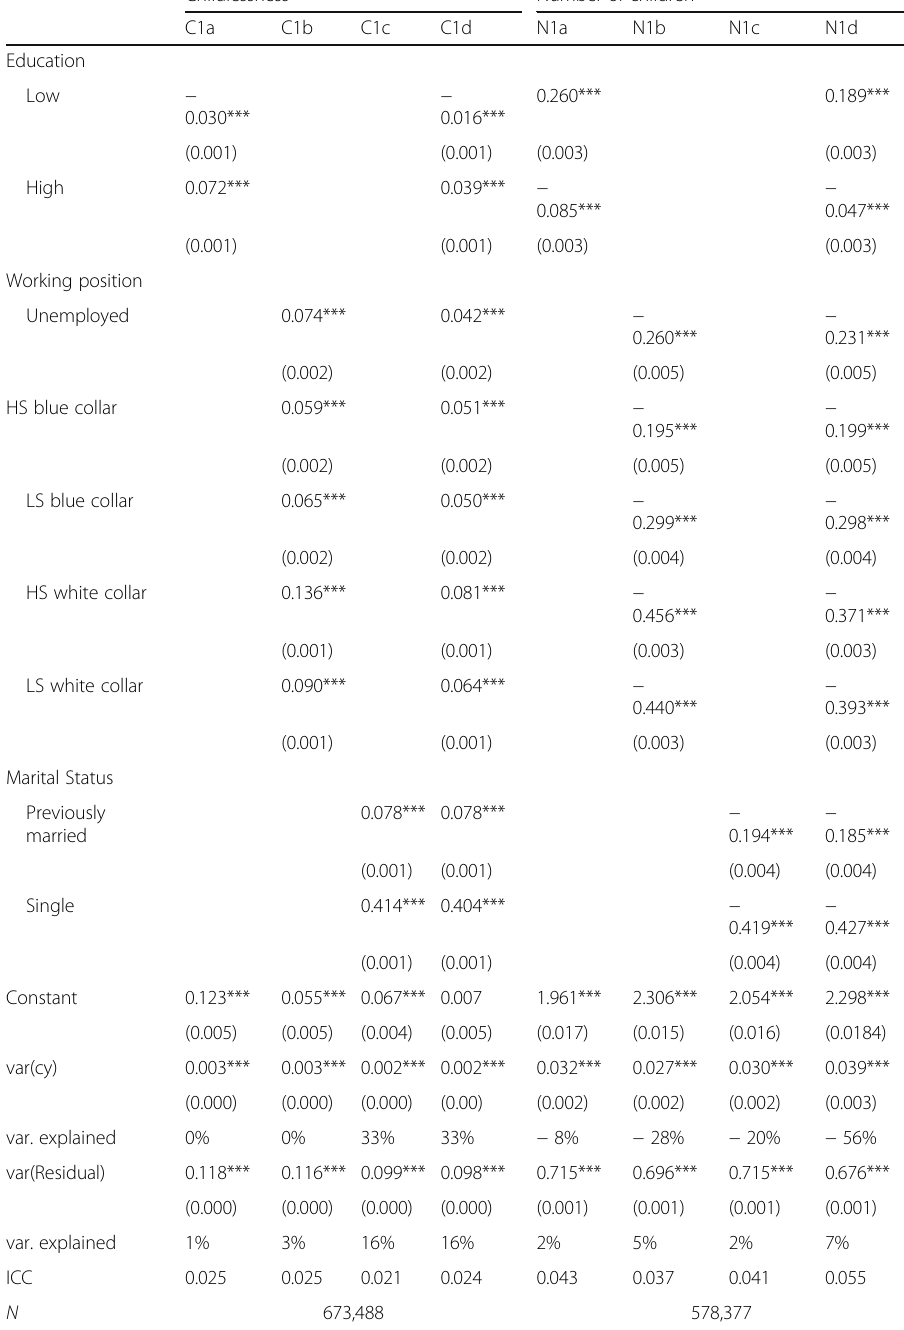
Table 2 Multilevel regressions of individual level predictors on childlessness (left table) and number of children (right